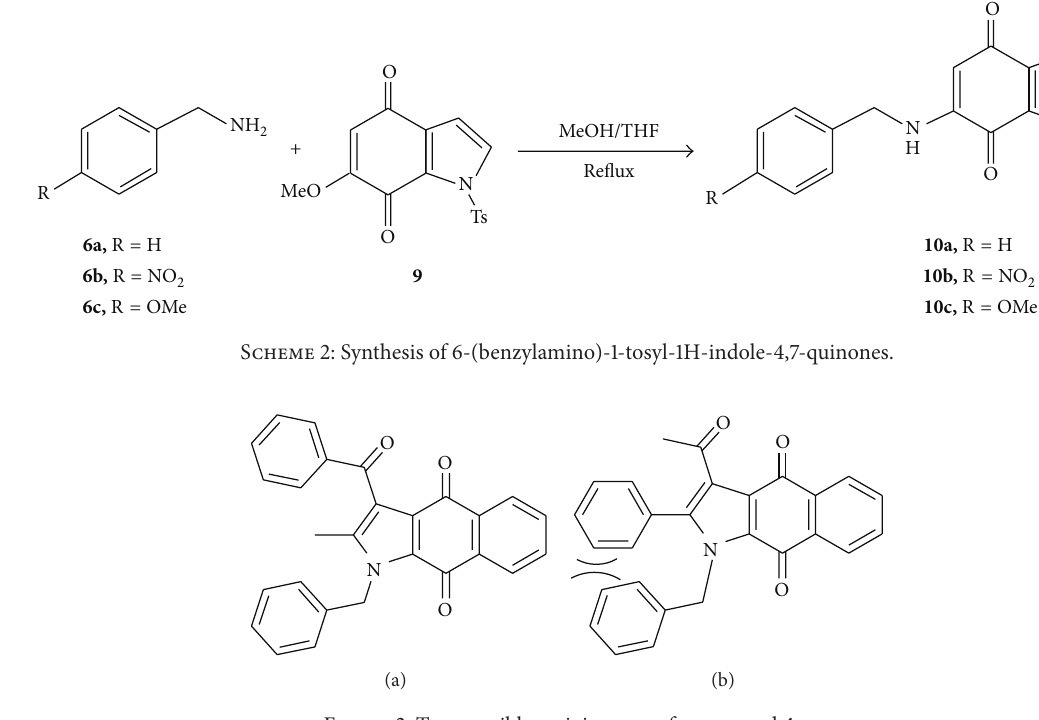
Figure 2: Two possible regioisomers of compound 4g